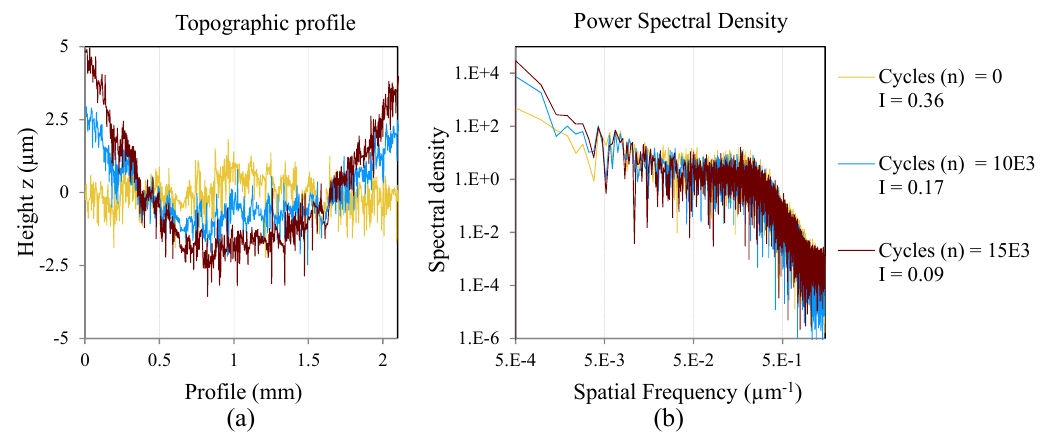
Figure 9. One area of inspection of the coupon C12 cycled at S max = 0.62 S ut ( a ) Topographic profile; ( b ) Power spectral density of the profile.